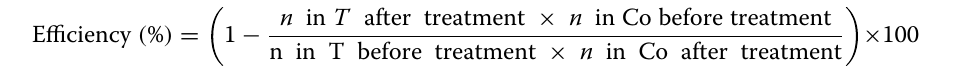
figure on next Fig. 1 Characterization of Purpureocillium lilacinum PL1 isolated from Bemisia tabaci . A Dead B. tabaci with the presence of mycelia on the cuticle. B Bemisia tabaci cadavers under stereomicroscope at 40 magnification. C Macroscopic morphology of P. lilacinum PL1 isolates in PDA × culture medium. D Microscopic morphology of P. lilacinum PL1 isolates under microscope at 1000 magnification. E Macroscopic morphology × of P. lilacinum PL1 re-isolated from B. tabaci using Koch postulates F Microscopic morphology of P. lilacinum PL1 re-isolated from B. tabaci using Koch postulates. G Phylogenetic tree based on the ITS gene sequences of P. lilacinum PL1 in this study and other known P. lilacinum strains in the GenBank database. The P. lilacinum PL1 in this study are marked in